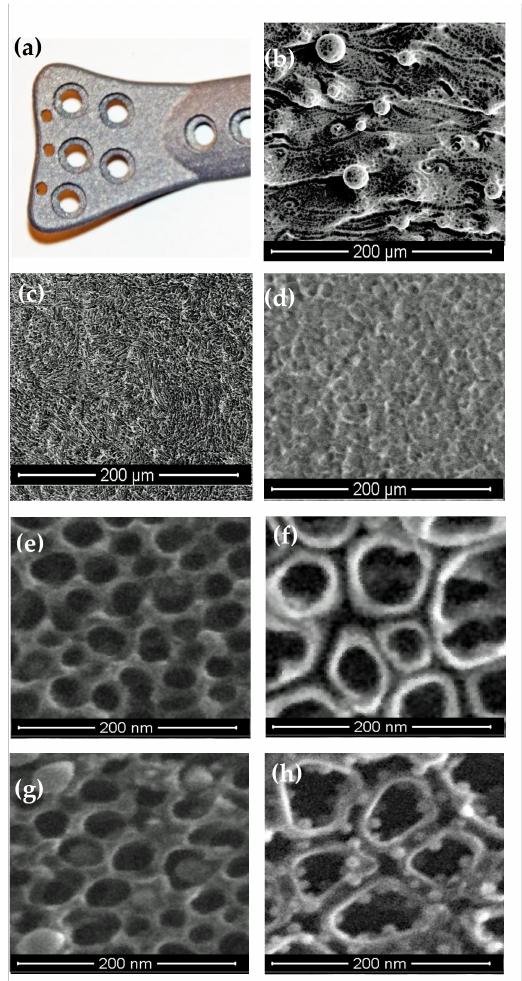
Figure 1. ( a ) Photography of the orthopedic implant produced using selective laser sintering of Ti6Al4V powder, SEM images of ( b ) the implant surface obtained, ( c ) implant surface after grinding and polishing, ( d ) surface modification of the implant by anodic oxidation using a 5 V potential, ( e ) the morphology of the TNT5 coating, ( f ) the morphology of the TNT15 coating, ( g ) the morphology of the TNT5 / AgNPs coating, and (h) the morphology of the TNT5 / AgNPs coating. The calculated values of ∆ (O–Ti) after the second sputtering were 75.3 and 76.6 eV, which, according to Atuchin et al. [37], confirm the presence of the titanium on the second oxidation state. Therefore, in Tables 1 and 2, both values are presented as Ti2 + . The XPS studies of the non-sputtered layer, which consists of separated tubes (TNT 15), revealed the presence of dual 2p 3 / 2 and 2p 1 / 2 peaks at a binding energy (BE) of c.a. 459.0 and 457.8, and 464.7 and 463.4 eV, respectively (Figure S2). The calculated ∆ (O–Ti) values of 71.2 and 72.2 eV, respectively, indicate the formation of oxides, in which titanium occurs at the + 4 (86%) and + 3 (14%) oxidation state. After the third sputtering of + + + TNT15, it is possible to see the layer consisting of Ti 4 (30%), Ti 3 (23%), and Ti 2 (37%) oxides, and Ti 0 (10%) (Tables 1 and 2, Figure